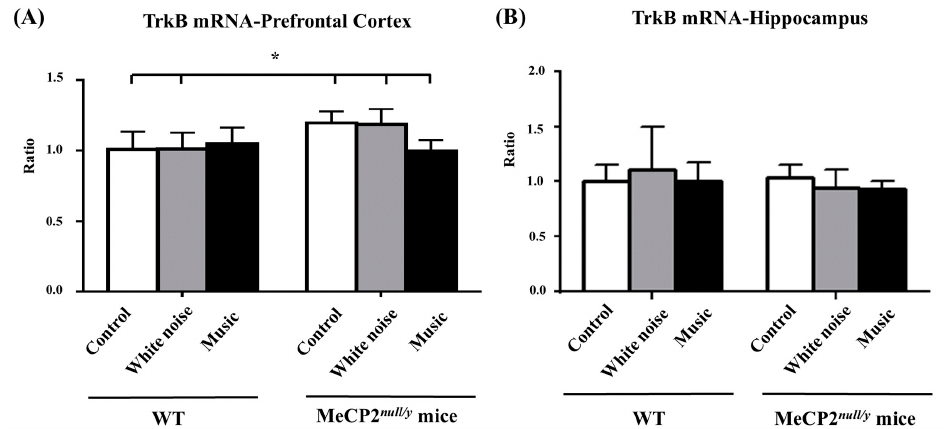
Figure 4. Comparison of TrkB mRNA expression between wild-type mice and mecp2 null/y mice in the PFC and hippocampus. ( A ) Mecp2 null/y mice that did not undergo a music-based intervention showed significantly increased TrkB mRNA expression in the PFC as compared with all wild-type mice and mecp2 null/y mice that underwent a music-based intervention. ( B ) TrkB mRNA expression was comparable in the hippocampus between wild-type mice and mecp2 null/y mice. (* p < 0.05).